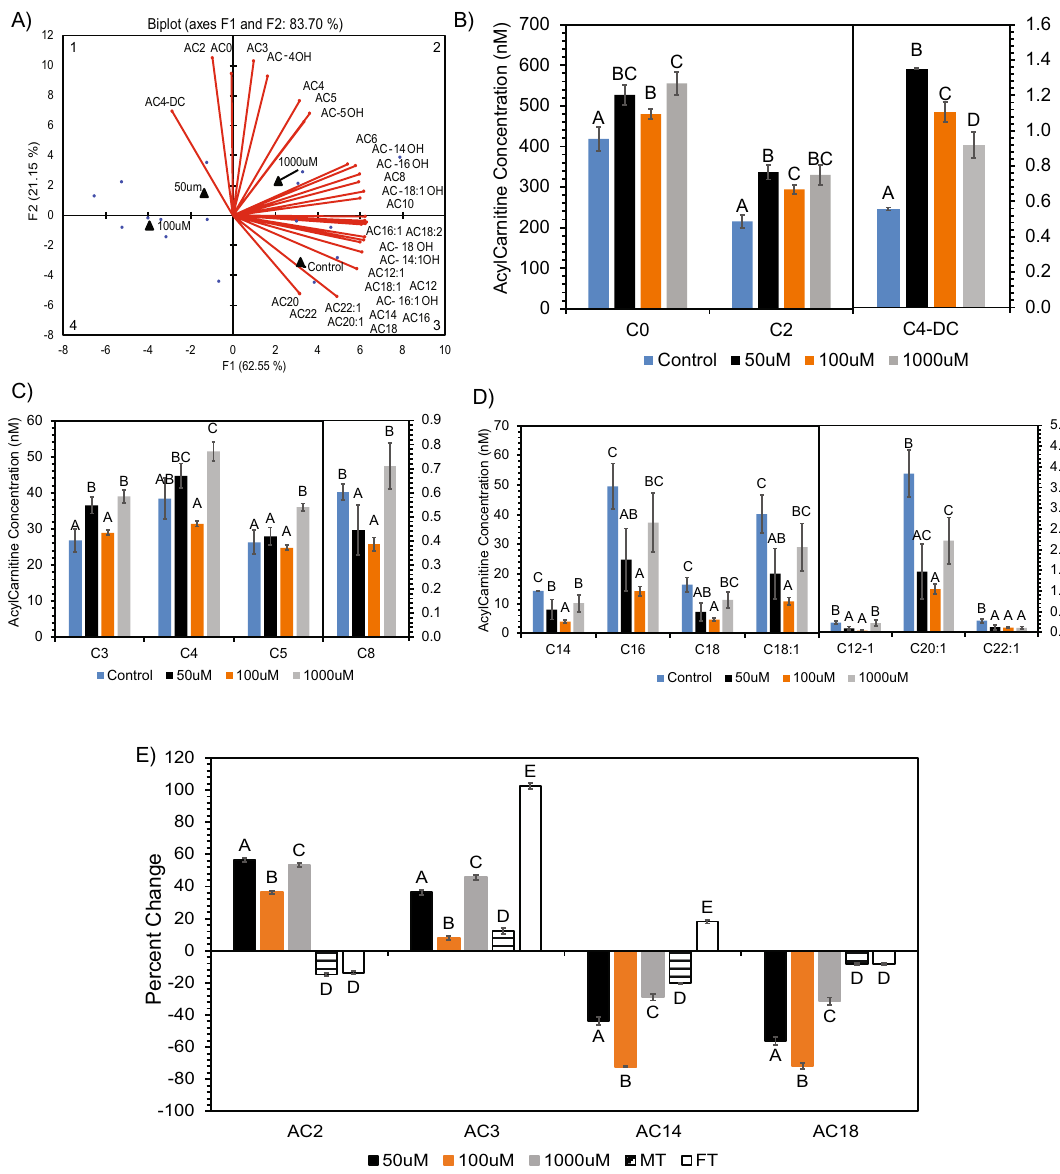
Figure 2. Alteration in free carnitine (C0) and acyl-carnitine (AC) composition after SCFA treatment. ( A ) PCA biplot showing relationship between SCFA treatment and carnitine molecular species. ANOVA revealed significantly (p < 0.05) altered carnitine molecular species in quadrant 1 ( B ), quadrant 2 ( C ), quadrant 3 ( D ) of the PCA. ( E ) Percent change of treatments vs respective controls for ANOVA significant (p < 0.05) acyl-carnitine species altered in both neuronal cells and Long Evans rat brain. Species determined via PCA and Differential Expression, respectively, prior to ANOVA. Bar charts representative of means ± standard error. Means represented by different superscripts are significantly different at p <